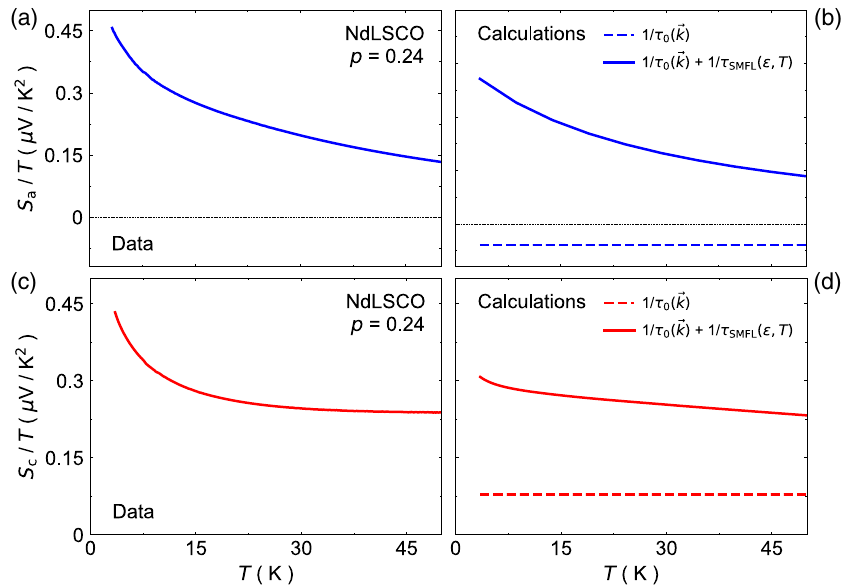
FIG. 8. Left: Seebeck coefficient of Nd-LSCO p ¼ 0 . 24 for both the a axis (blue) (a) and c axis (red) (c). Right: corresponding calculated Seebeck coefficients (b,d) for a momentum-dependent but energy-independent scattering rate 1 = τ 0 ð (see Appendix A for more details) inferred from the elastic scattering rate extracted from ADMR measurements [17] (dashed line) and a momentum- and energy-dependent skewed scattering rate of the form 1 = τ 0 ð